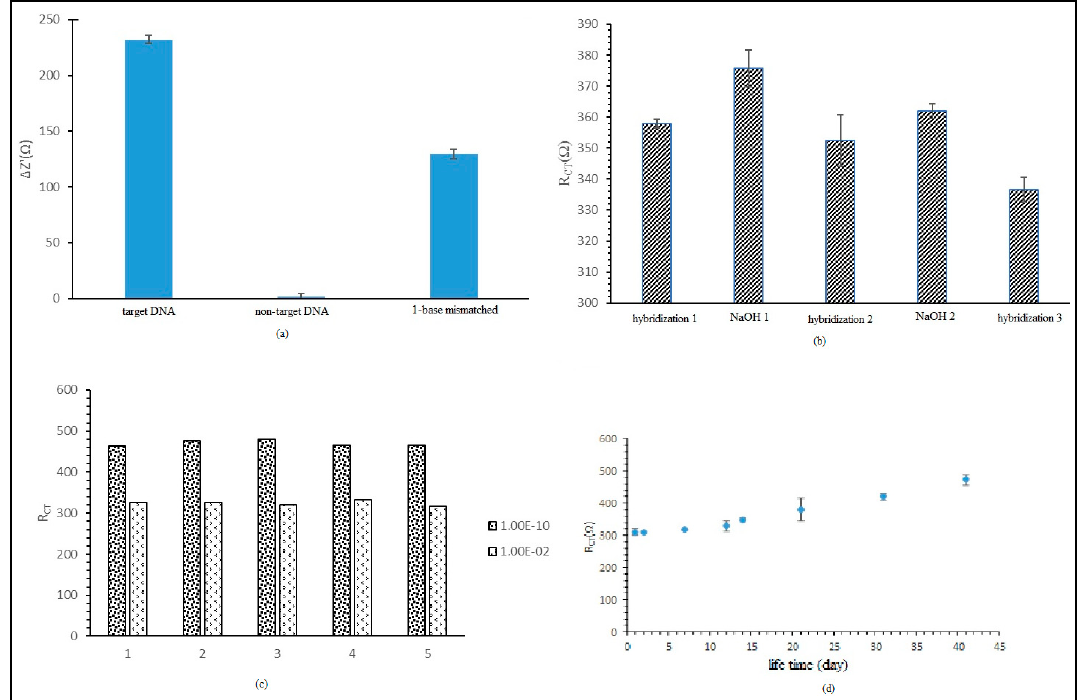
Figure 7. ( a ) Label-free E. coli DNA biosensor selectivity on target DNA, non-target DNA, and Figure7. ( a )Label-free E.coli DNAbiosensorselectivityontargetDNA,non-targetDNA,andsingle-base single-base mismatched DNA. ( b ) Regeneration for label-free E. coli DNA biosensor. ( c ) mismatchedDNA.( b )Regenerationforlabel-free E.coli DNAbiosensor. ( c )Reproducibilityforlabel-free Reproducibility for label-free E. coli DNA biosensor. ( d ) Lifetime effect of label-free E. coli DNA E. coli DNA biosensor. ( d ) Lifetime e ff ect of label-free E. coli DNA